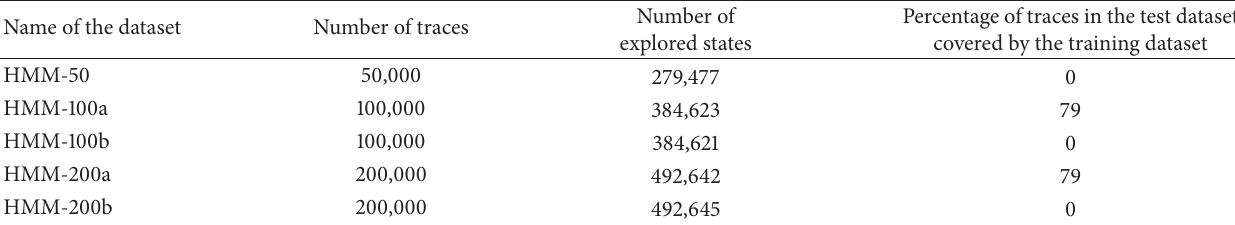
Table 2: Information of training datasets for the